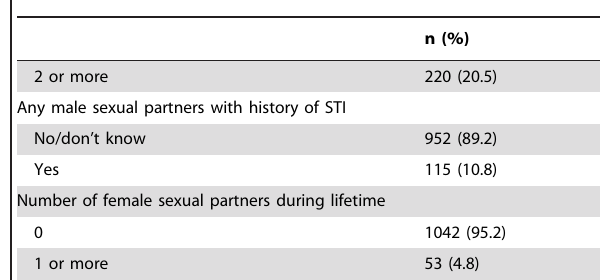
Table 1. Characteristics of women from the CARE Project